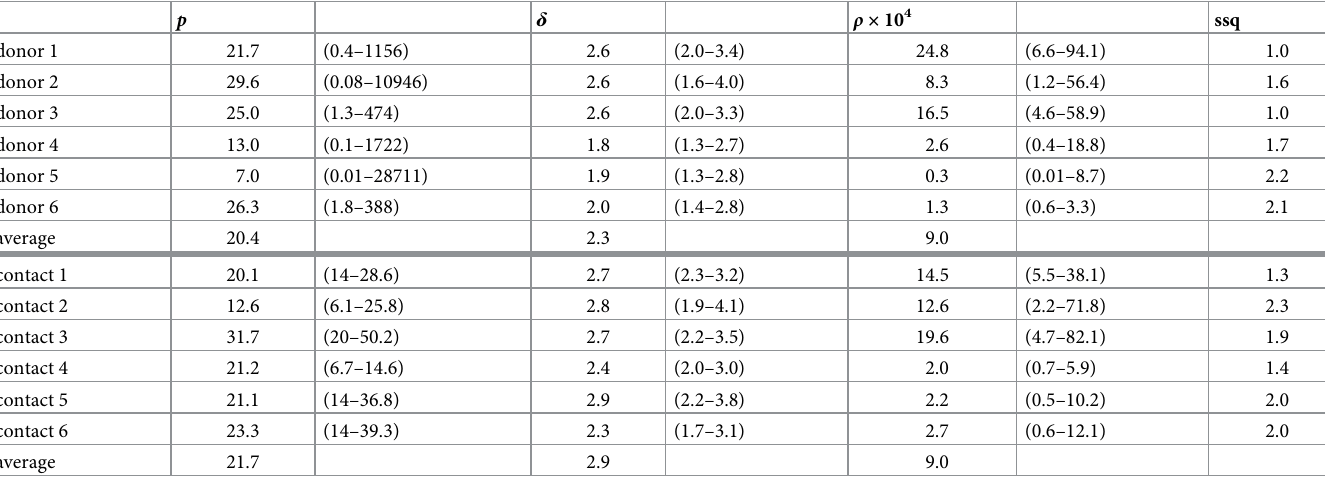
Table 2. Individual parameter estimates for donor and contact